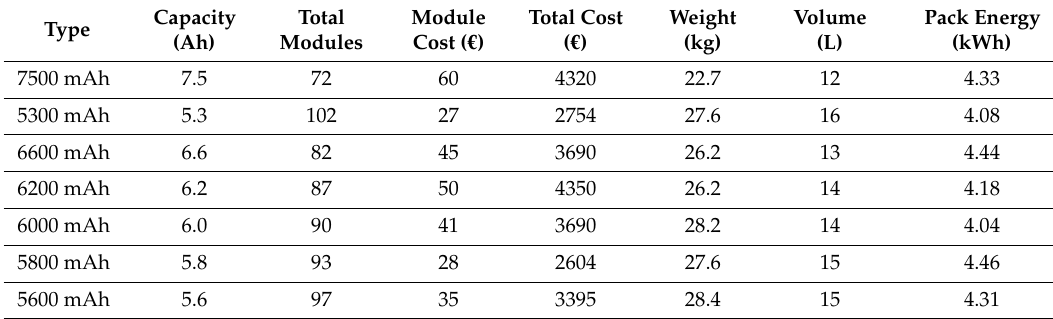
Table 2. Comparison of module characteristics.